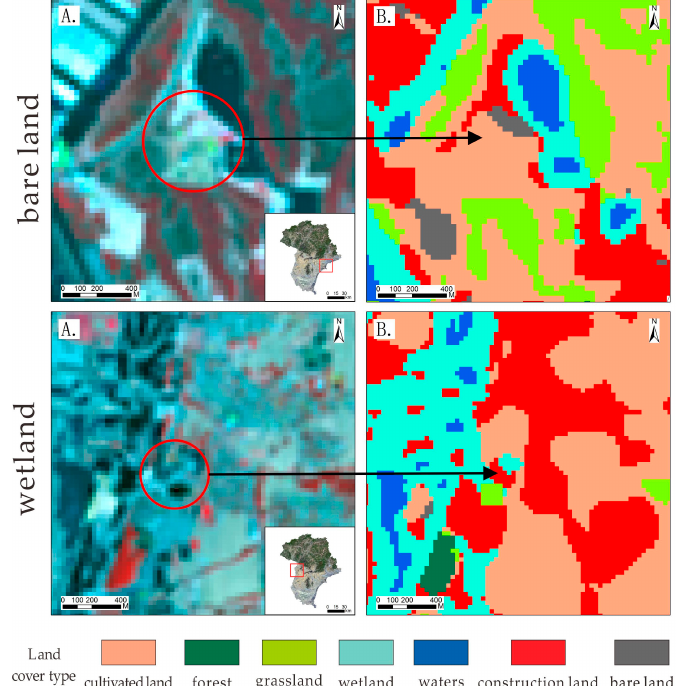
Figure 9. Detailed maps of bare land and wet land identification (A: Landsat 8 OLI (RGB: Bands 5, 4, 3); B: DCNN).